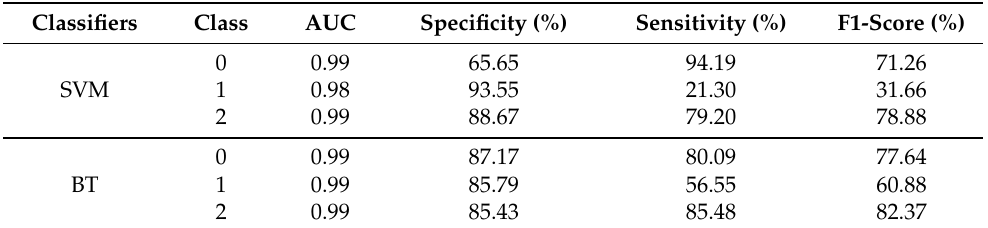
Figure 6. Confusion matrix for the ( a ) SVM classifier, and ( b ) BT classifier, applied on EDA data. Table 4. Relative performance evaluation of the SVM and BT classifiers on the three classes, with EDA data